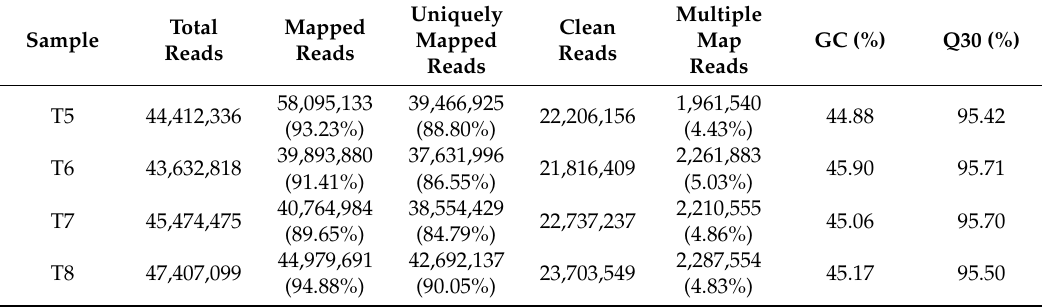
Figure 1. Differentially expressed genes (DEGs) of cotton genotypes at given time points during the nitrogen resupply treatments. ( A ) Number of DEGs identified by pairwise comparisons between nitrogen starvation and resupply treatments. Upregulated (black) and downregulated (red) genes were quantified. Based on DESeq software, genes with p -value < 0.05 were considered as significantly differential expression, and a 2-fold variance was used to identify the genes differentially expressed between the two libraries. ( B ) Venn map of DEGs among different combinations of comparisons at given time points. XLZ-30-Roots (0 h vs. 6 h), XLZ-30-Shoot (0 h vs. 6 h), CCRI-69-Root (0 h vs. 6 h), and CCRI-69-Shoot (0 h vs. 6 h) indicate cotton genotypes resupplied with nitrogen being treated with nitrogen free solution for 5 days. 2.3. Gene Ontology (GO) Enrichment Analysis of DEGs To understand the functions of all these DEGs, we performed gene ontology (GO) analysis to classify all the DEGs into respective biological, molecular, and cellular components. According to biological function, the DEGs were mainly mapped to metabolic, cellular processes, and signal- organism (Figure 2). In the cellular component, most of the DEGs were significantly enriched in the DEGs that mapped to membrane, cell, cell part, membrane part, and organelle (Figure 2). According to molecular process, the DEGs that mapped to binding, catalytic activity, and transporter activity constituted a high proportion under N starvation and resupply treatments (Figure 2). Thus, DEGs